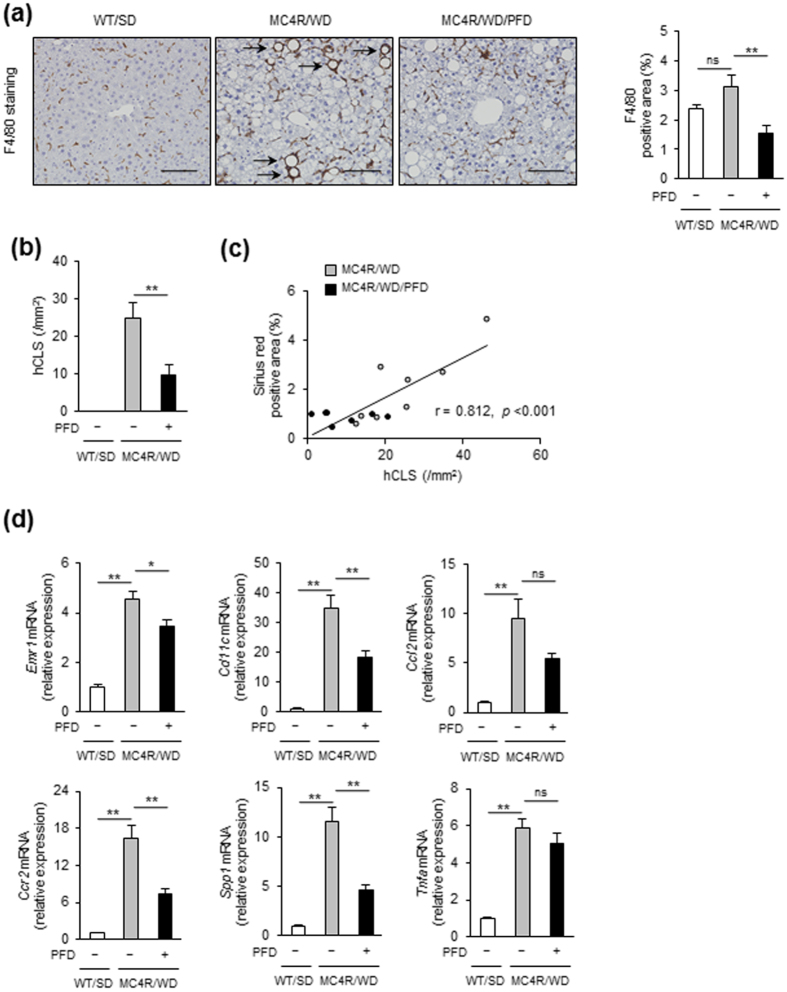
PFD inhibits hCLS formation in the liver of WD-fed MC4R-KO mice.(a) Representative images and quantification of F4/80 immunostaining of the liver sections from WD-fed MC4R-KO mice after treatment with PFD. Arrows indicate “hepatic crown-like structure (hCLS)”. (b) Quantification of hCLS number in the liver sections. (c) Correlation of the number of hCLS with the Sirius red-positive area. (d) mRNA expression of genes related to macrophage markers, proinflammatory cytokines and chemokines in the liver. Original magnification, ×200. Scale bars, 100 μm. *p < 0.05, **p < 0.01; ns, not significant. n = 6–8.